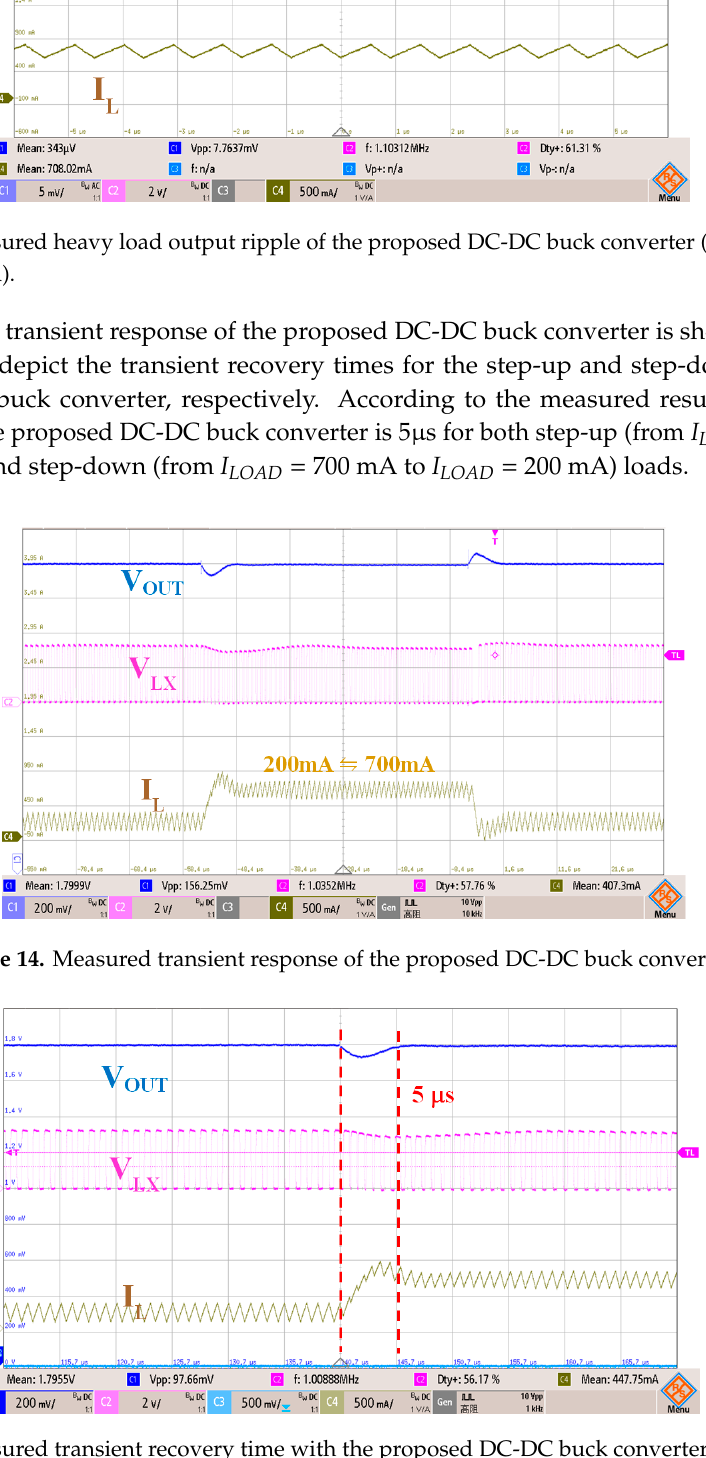
Figure 15. Measured transient recovery time with the proposed DC-DC buck converter for a step-up load from 200 mA to 700 mA.